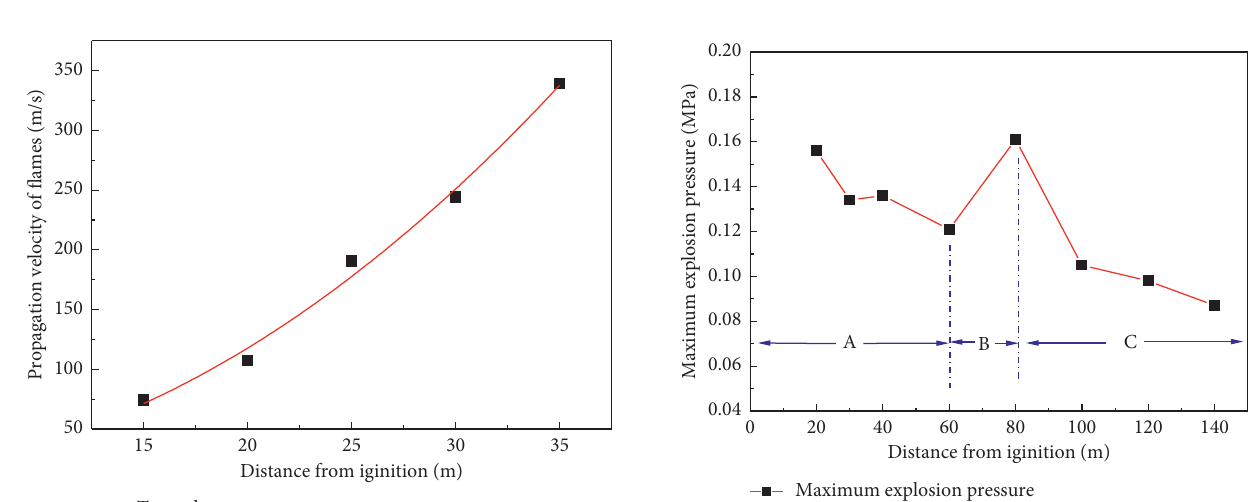
Figure 6: The maximum explosion pressures at various mea- surement